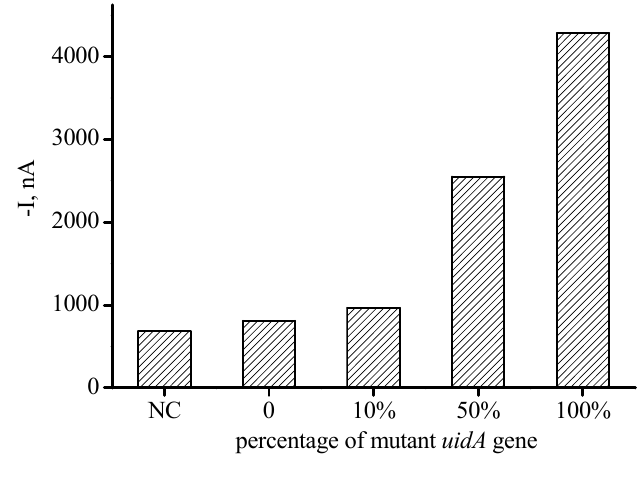
Figure 5. the result of the multiplexed electrochemical analysis of PCR amplicons from samples with different percentage of mutant uidA